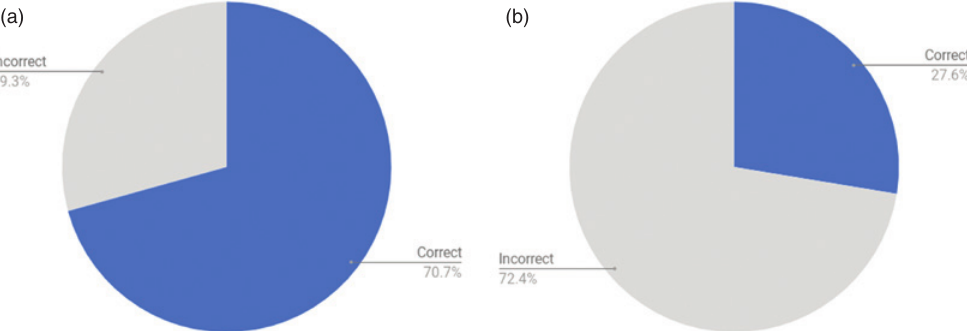
figure 4a: answer distributions for the checK question for the TesT (n = 458, 70.7% correct) cohort; figure 4b: answer distributions for the checK question for the coNTRol (n = 823, 27.6% correct) cohort (source: author) (a)